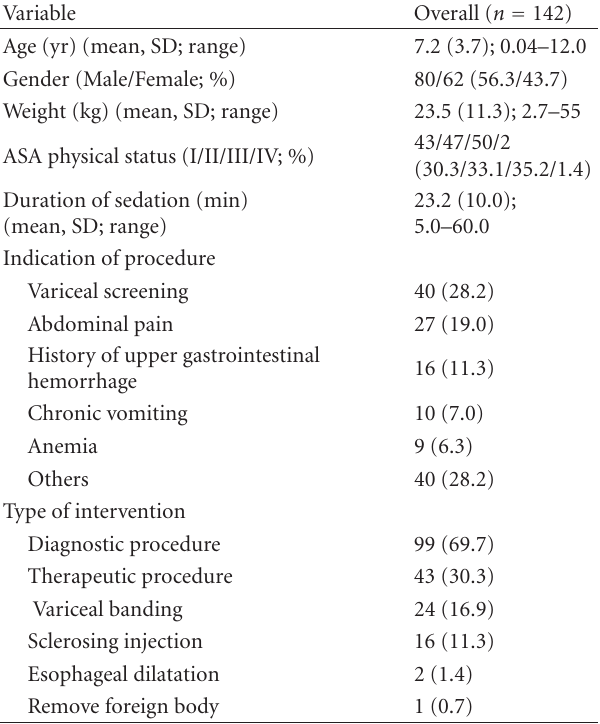
Table 1: Patient characteristics, duration of sedation, and indica- tion of